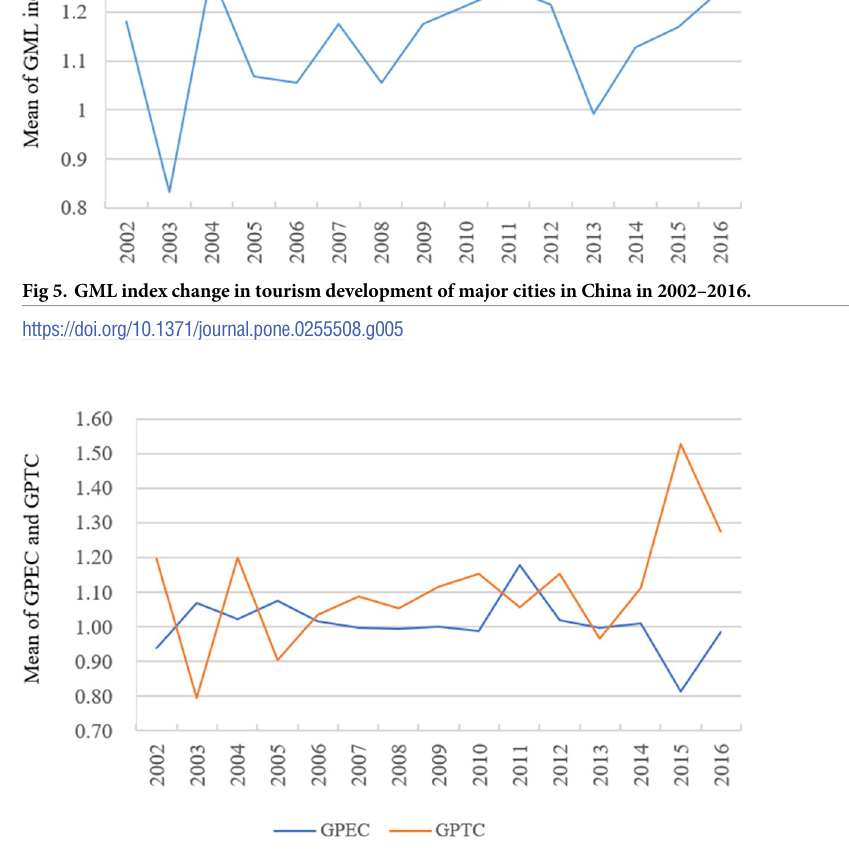
Fig 6. Changes in GPEC and GPTC in tourism development of major cities in China in 2002–2016.